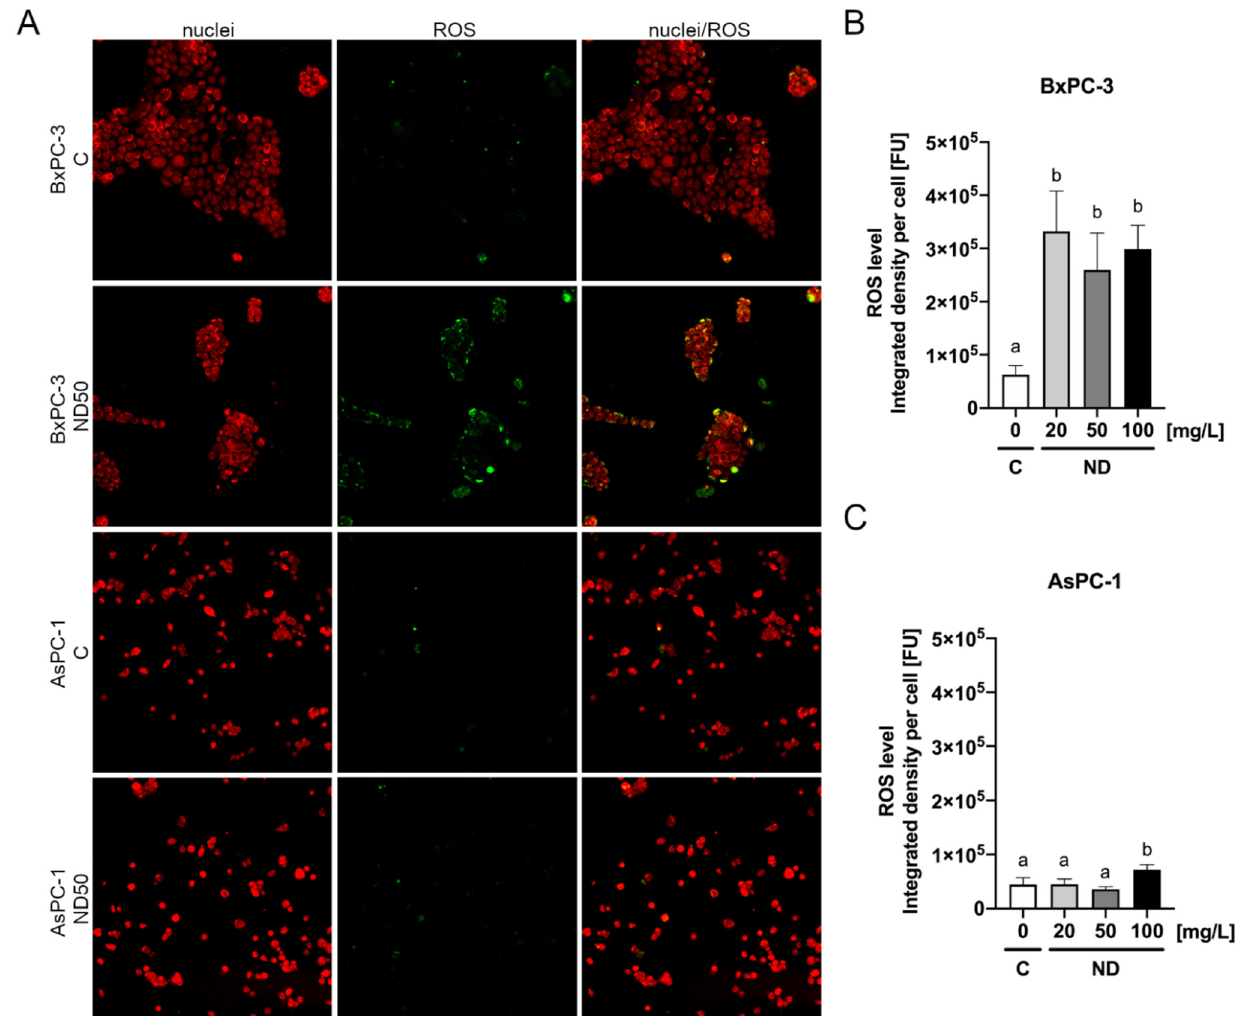
Figure 10. ROS detection after 2 h of incubation of the AsPC-1 and BxPC-3 cell lines with ND at the concentrations of 20 mg/L, 50 mg/L, and 100 mg/L determined using the general oxidative stress indicator CM-H2CFDA ( A ). The results are presented as the integrated density per cell (mean from seven replications with standard deviation) ( B , C ). Different letters above columns indicate statistically significant differences ( p ≤